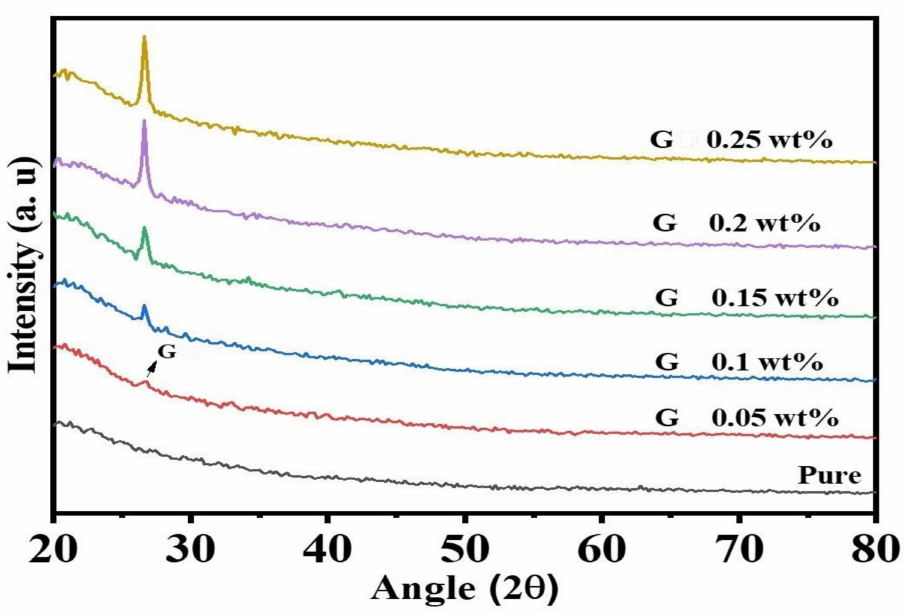
Figure 6. X -ray Diffraction (XRD) analysis of the